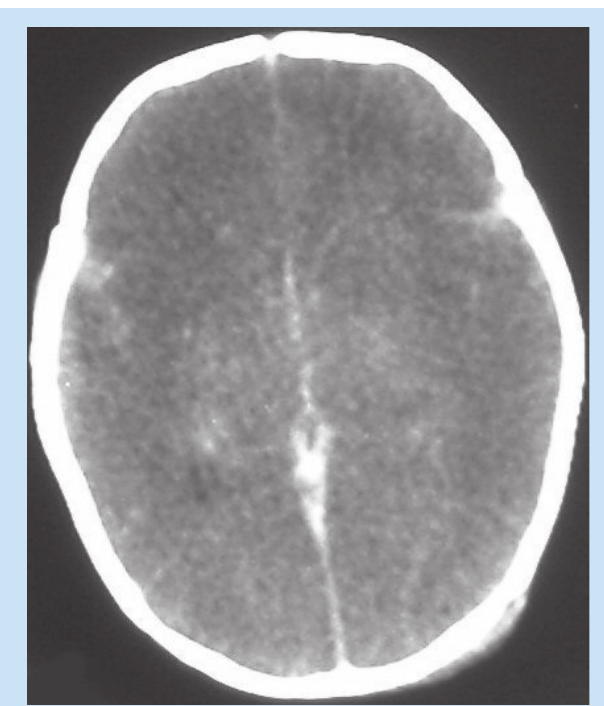
Fig. 2.4d. DWI demonstrated signal abnormality in the perirolandic region (arrow) which is susceptible to hypoxic injury. Fig. 2.4b. Complete loss of cortical density and effacement of the surface